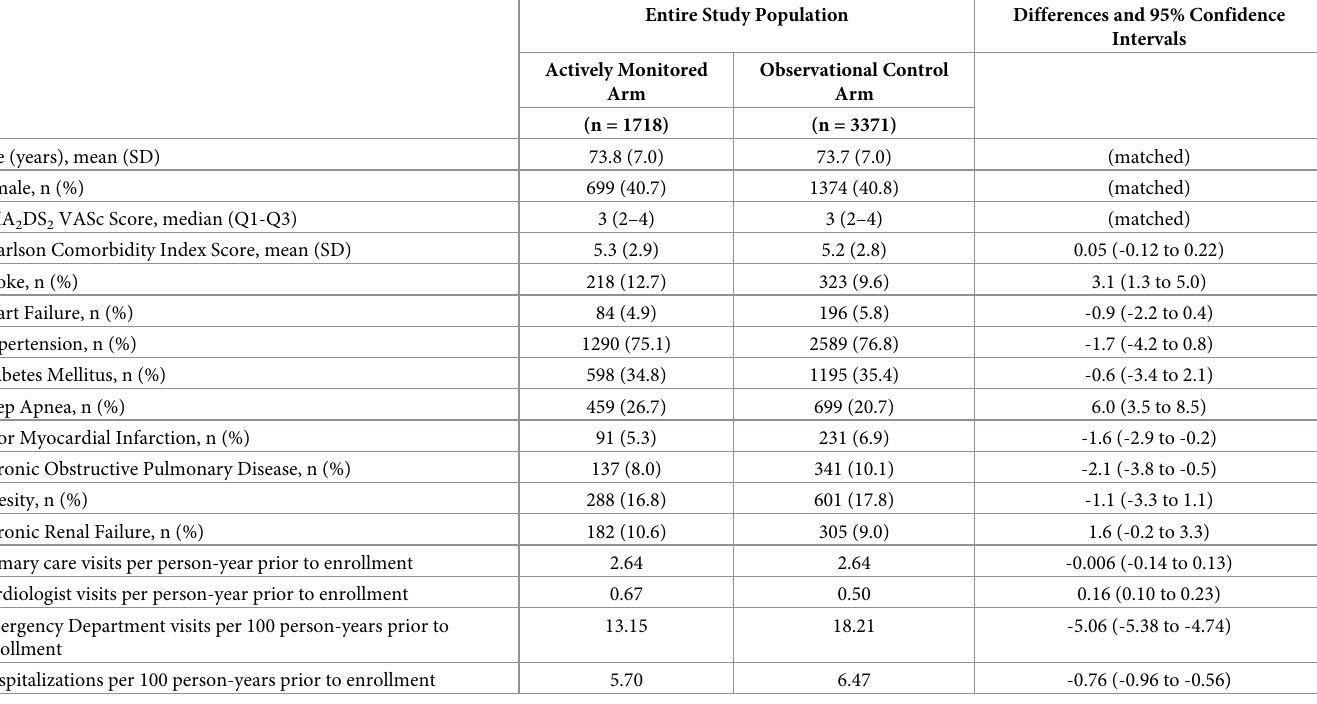
Table 1. Demographic characteristics at baseline of monitored individuals and matched controls.